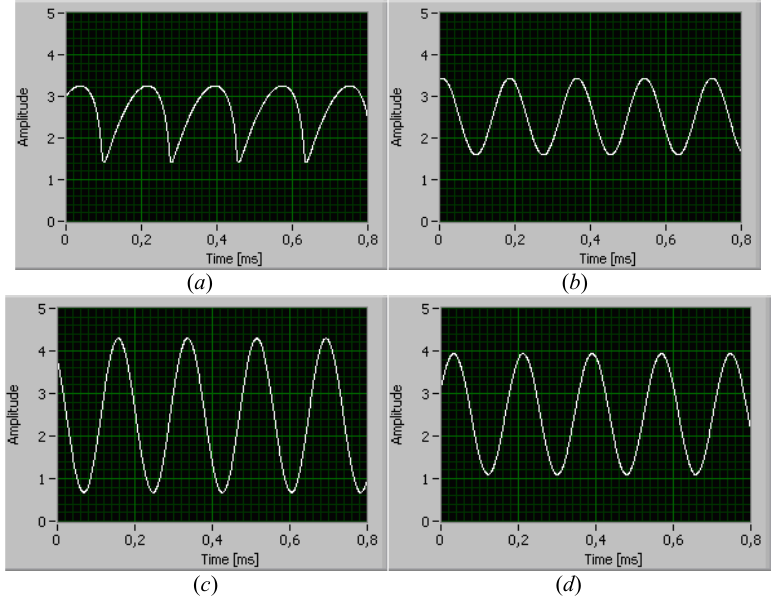
( ) u t SAD on the Gunn diode obtained in the absence of s χ 0  ( b ), χ 0.8   ( d n n